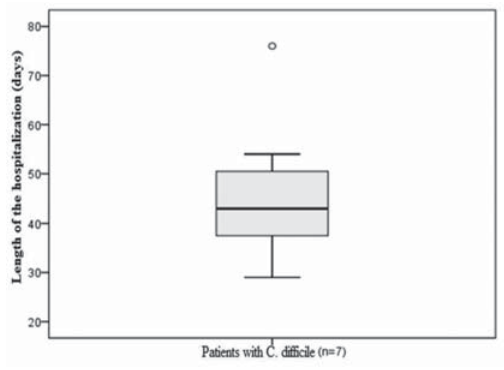
FIGURE 3. Length of hospitalization for patients with Clos- tridium diffi cile infection compared to patients without infec- tion with mean length of hospitalization of 28.8 days (Z=2.282;